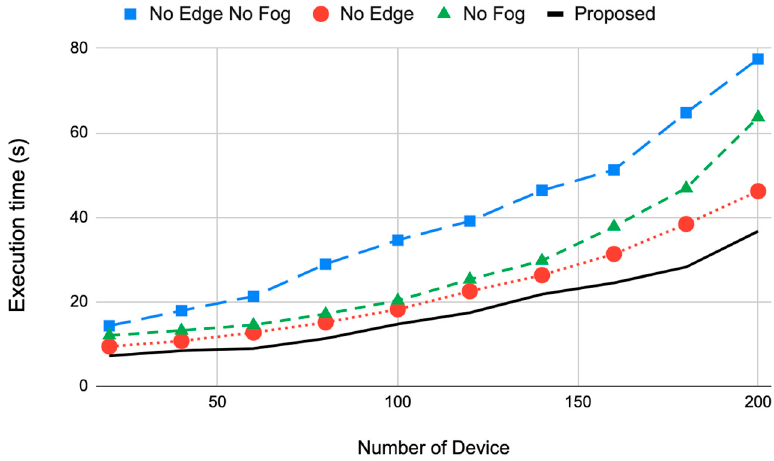
Figure 4. The execution time of the four system configurations for different numbers of devices.